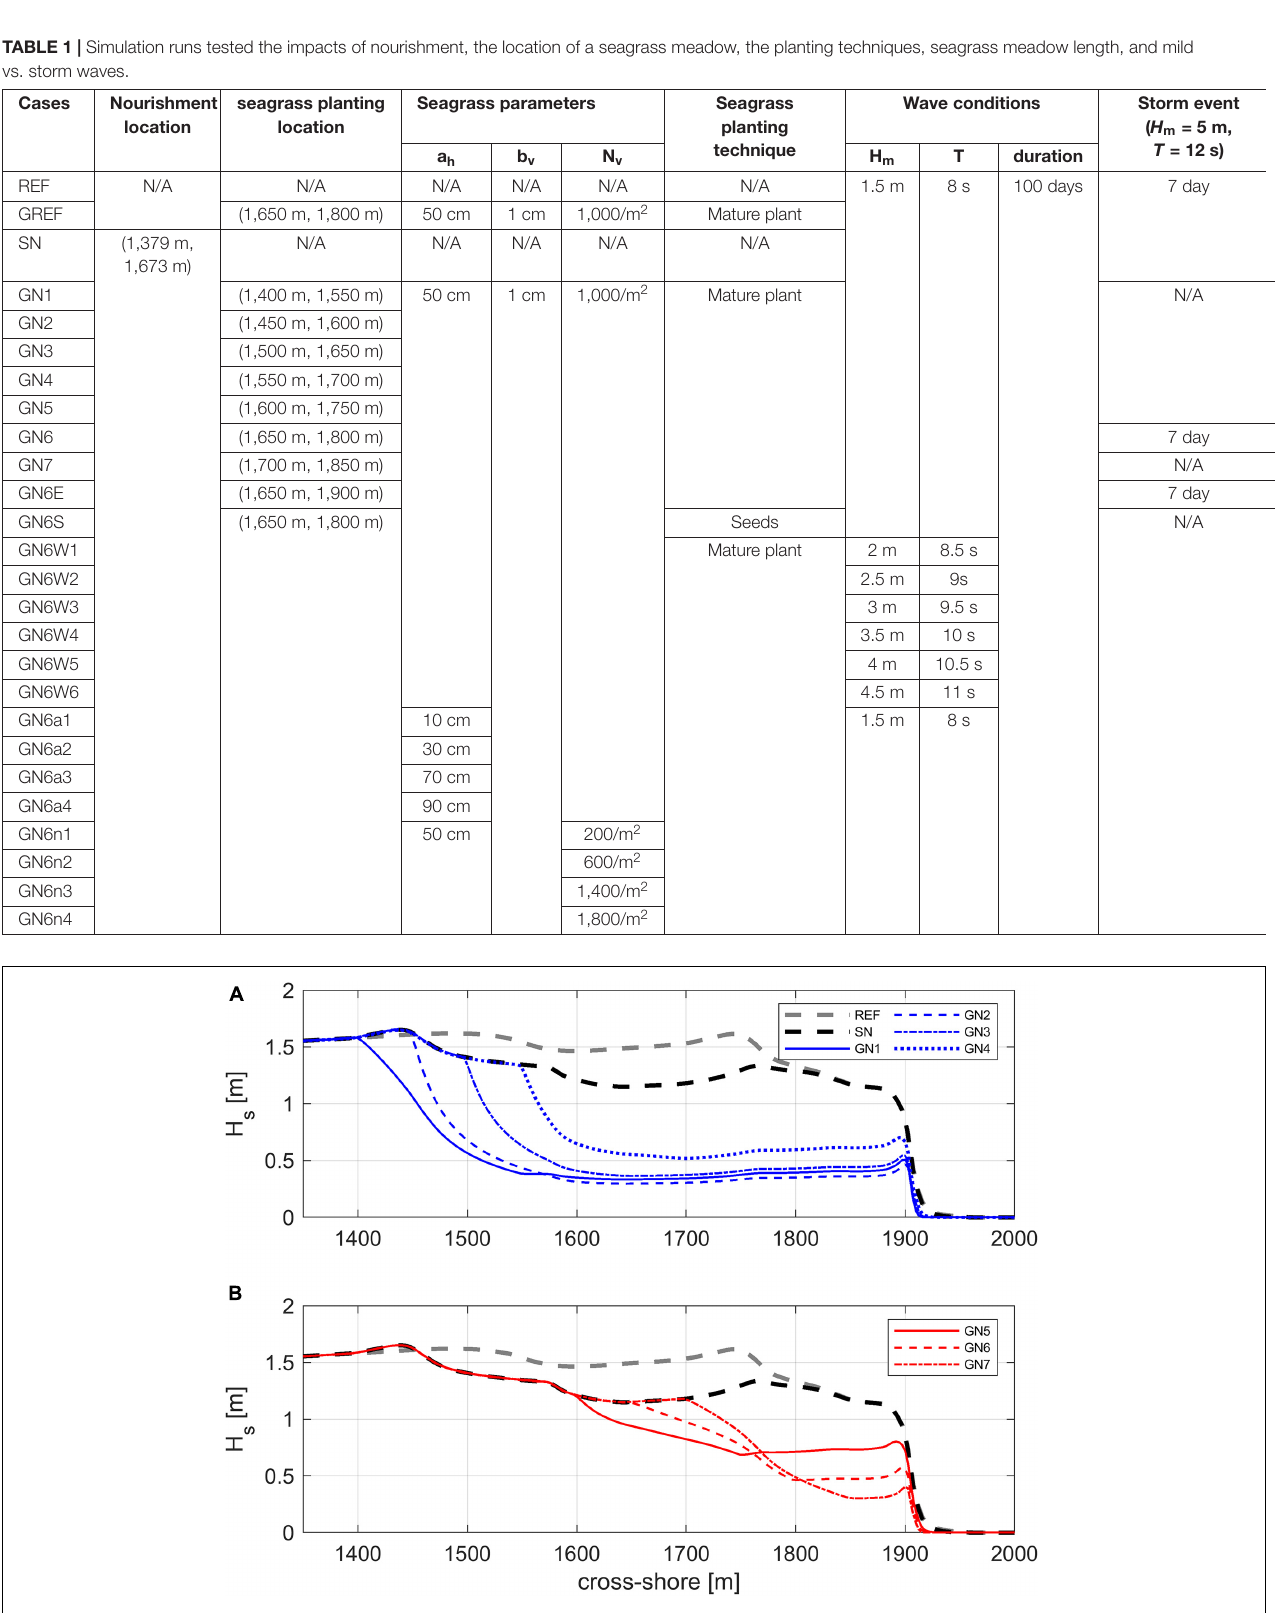
FIGURE 3 | Cross-shore wave height distribution under mild wave (i.e., H m = 1.5 m, T = 8 s) for: (A) case REF, SN, GN1-4; and (B) case GN5-7.